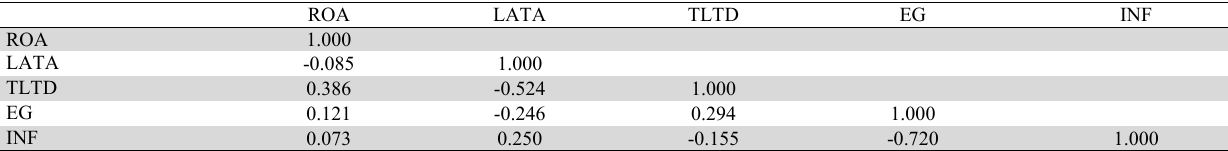
Variable correlation